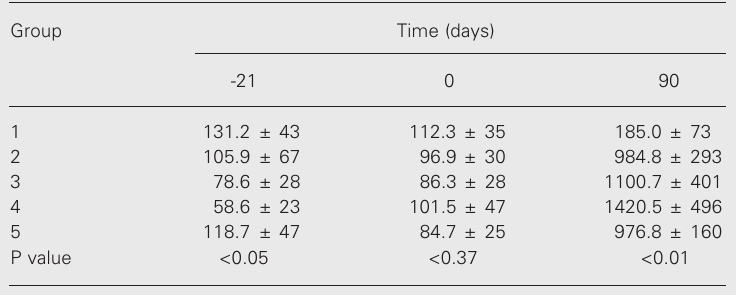
Table 1. Serum cholesterol levels at surgery (21 days before randomization: -21),